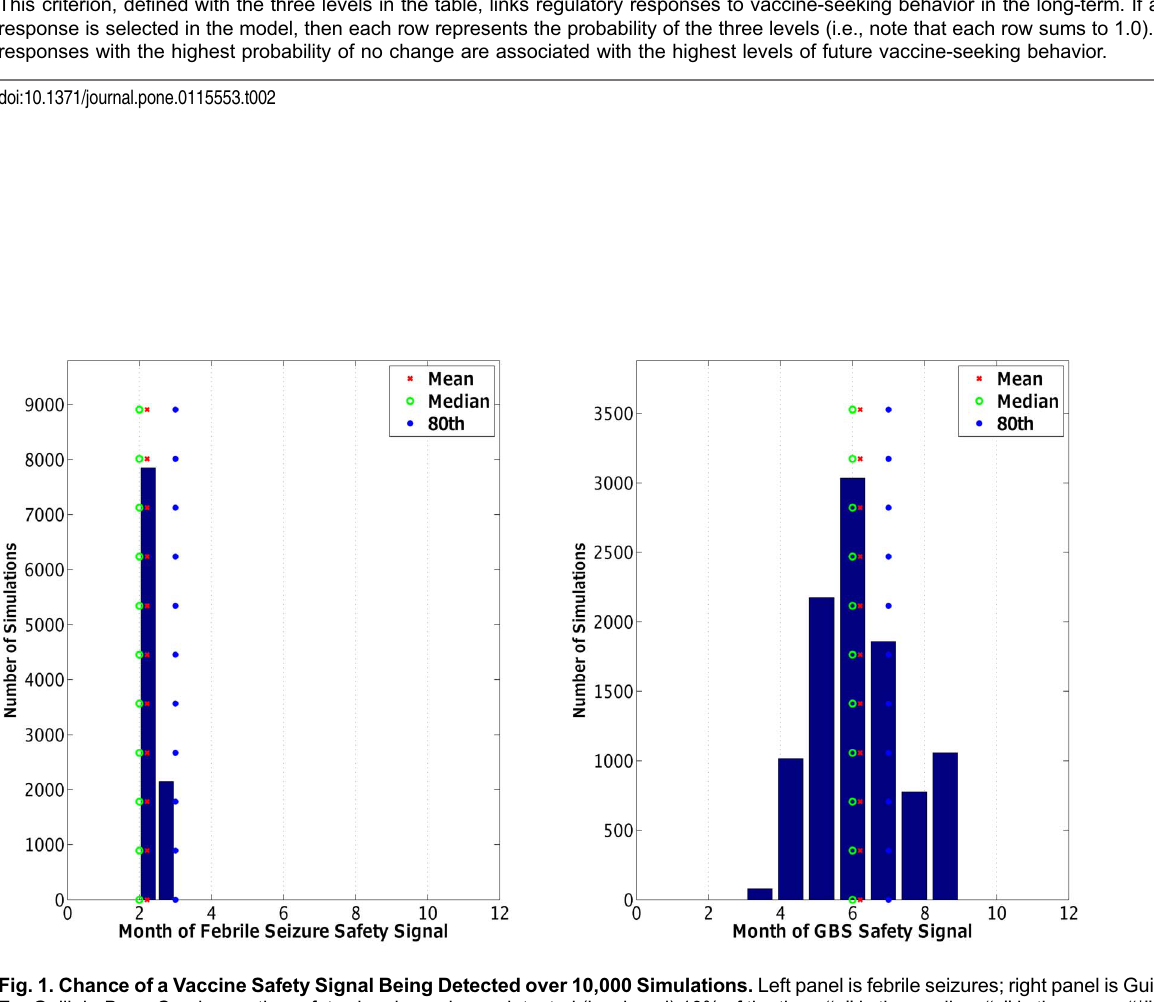
Fig. 1. Chance of a Vaccine Safety Signal Being Detected over 10,000 Simulations. Left panel is febrile seizures; right panel is Guillain-Barre Syndrome. For Guillain-Barre Syndrome, the safety signal remains undetected (is missed) 10% of the time. ‘‘o’’ is the median, ‘‘x’’ is the mean, ‘‘*’’ is the 80th percentile. Other details in S1